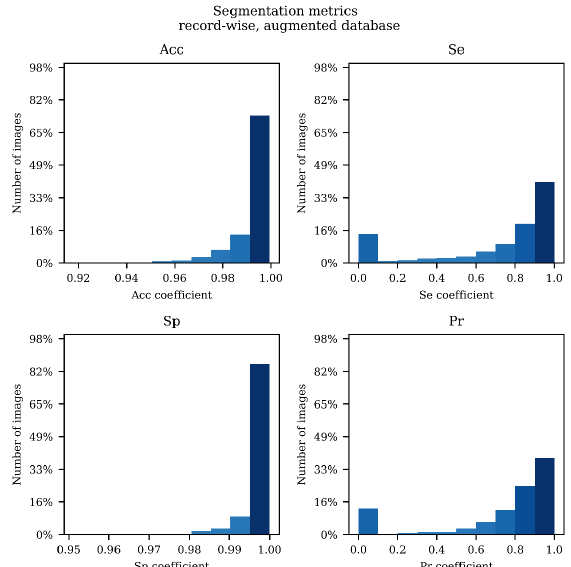
Figure A4. Histograms of metrics for segmentation results on a test set for a network trained on the augmented database with 5 -fold record-wise cross-validation. Acc — accuracy; Se — sensitivity; Sp — specificity; Pr — precision.